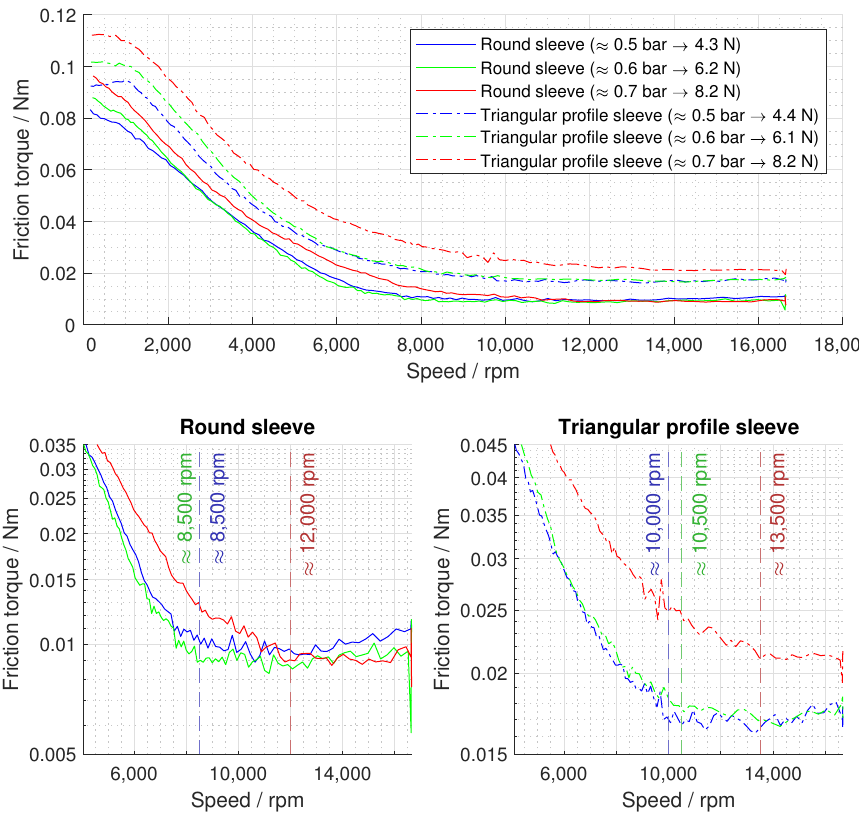
Figure 9. Torque and lift-off during the coast-down